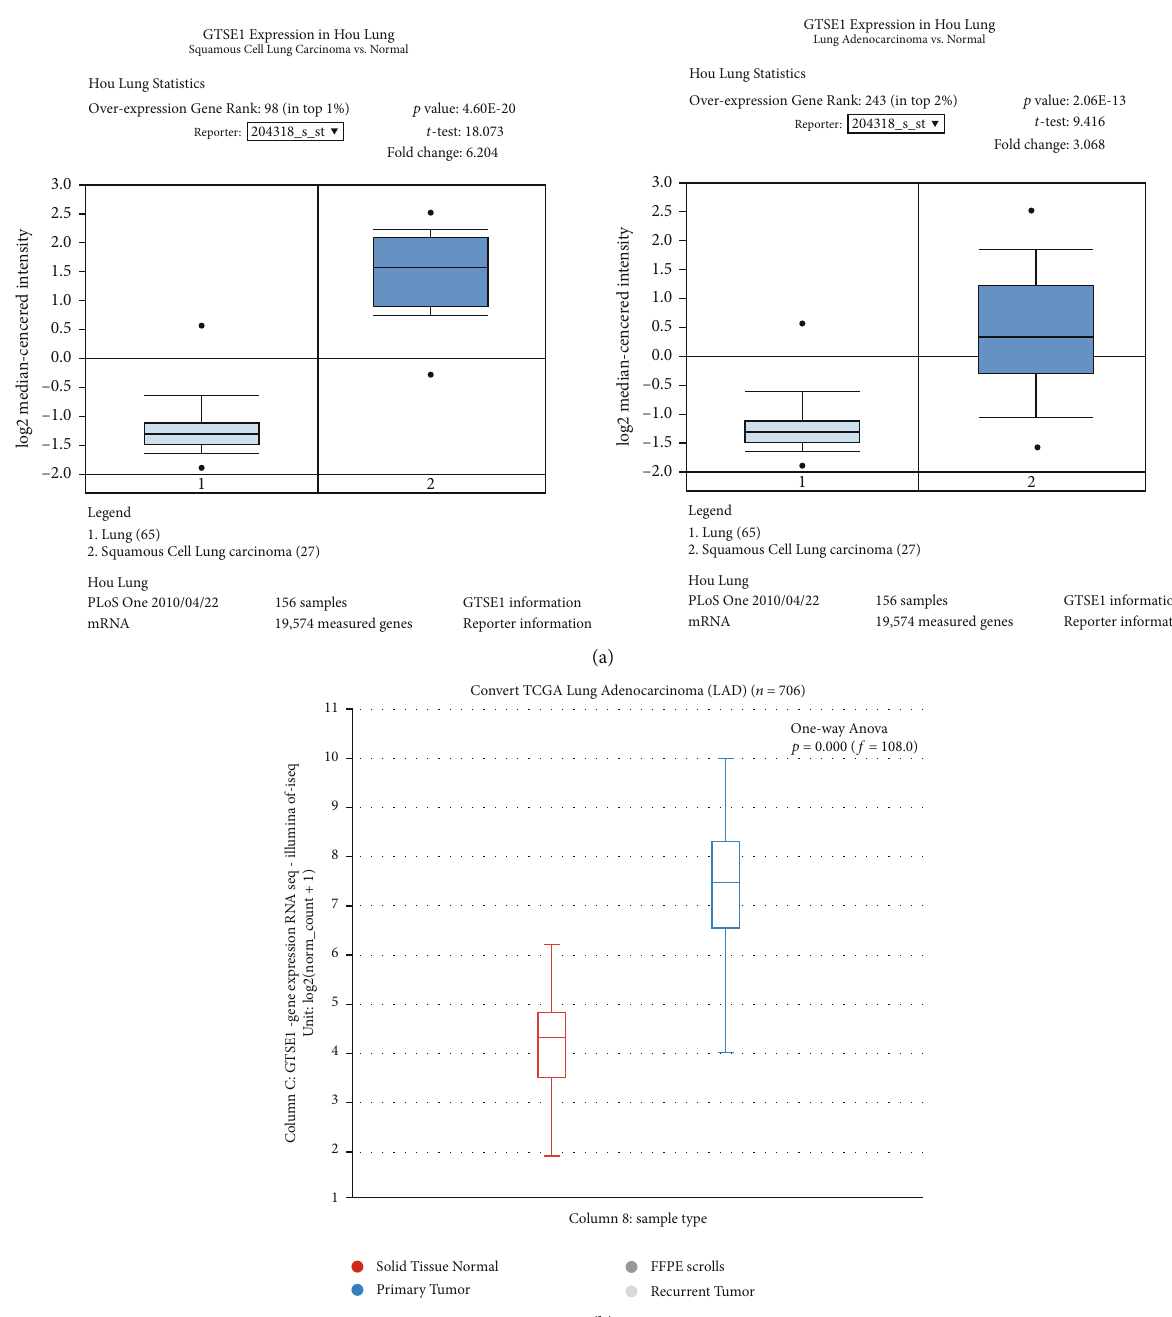
Column 8: sample